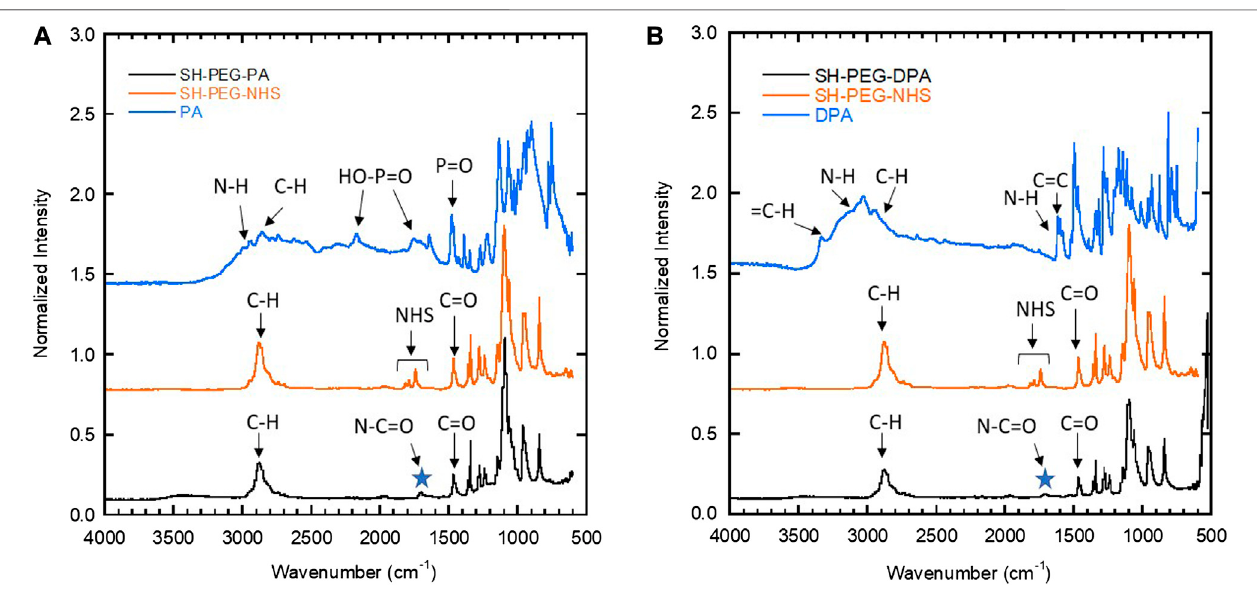
FIGURE4| FTIRspectraofthetwostartingmaterialsand theresultingchelatingagentmolecule for (A) SH-PEG-PAand (B) SH-PEG-DPA. Both (A) and (B) show the presence of an amide bond at 1700 cm − 1 (noted by the star) and the disappearance of the peaks associated with the NHS group, seen around 1750 – 1850 cm − 1 in the SH-PEG-NHS spectra but not in the fi nal product in (A) or (B) .